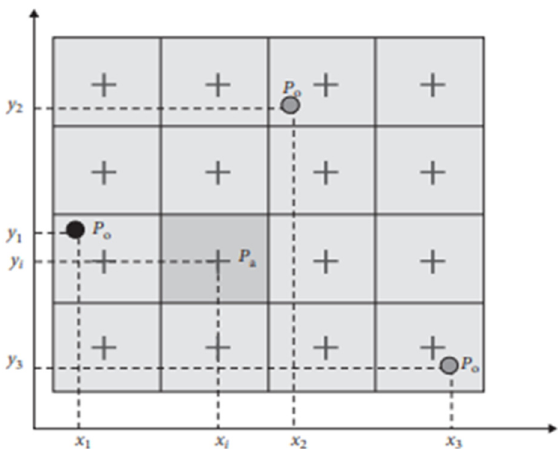
Figure 2. Scheme for the interpolation of ANA rain gauges with the CMORPH cell at the point where the erosion event (Pa) occurred. Reprinted/adapted with permission from Ref.: [14]. Copyright 2018, Adv. Meteorol .